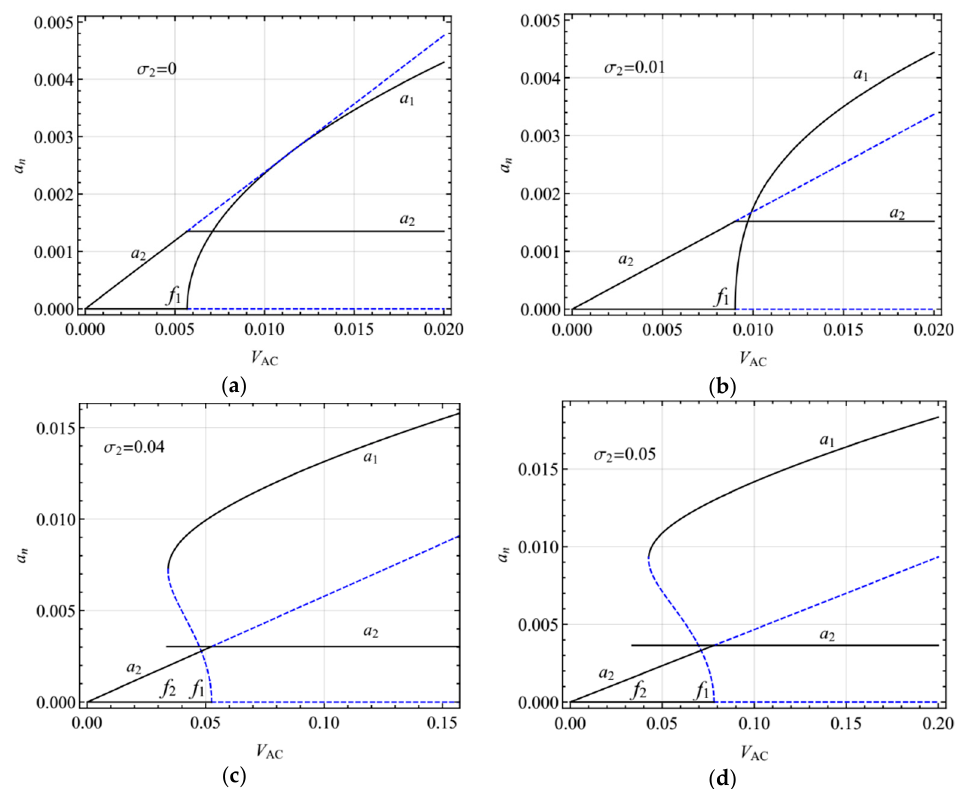
Figure 10. Response amplitude varying with the exciting amplitude in the primary resonance of the second mode for different exciting frequencies: ( a ) σ 2 = 0; ( b ) σ 2 = 0.01; ( c ) σ 2 = 0.04; ( d ) σ 2 = 0.05.